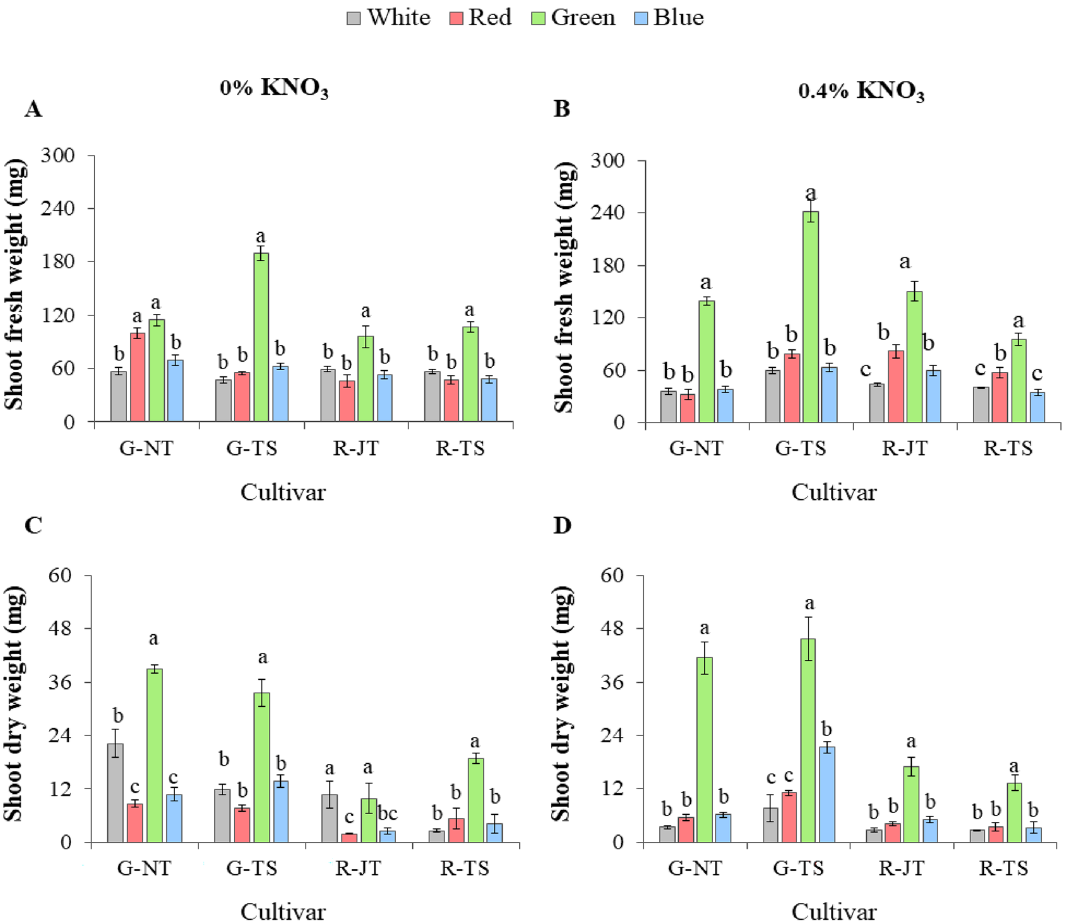
Figure 6. Fresh weight ( A , B ) and dry weight ( C , D ) of shoots from four light treatments; white LEDs (W), monochromic red (R), green (G) and blue (B) LEDs with 0% and 4% of KNO3 priming among four holy basil varieties; G-NT ( A ), G-TS ( B ), R-JT ( C ) and R-TS ( D ) subsequently grown with white LEDs for 15 days under fully controlled environments. Different letters above bars indicate significant differences within group of the same basil at P < 0.05. Data are mean values (n = 4) ±